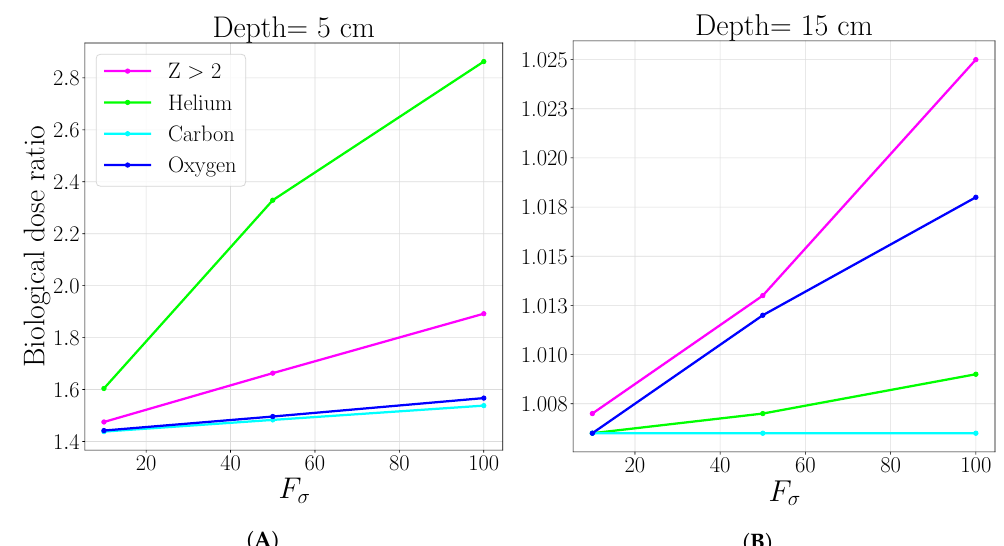
Figure A2. Ratio between the biological dose obtained by considering a modified cross-section for (separately) Helium, Carbon, Oxygen, Z > 2 and the biological dose of primary protons, at 50 mm depth ( A ), 150 mm ( B ) as a function of cross-section scaling factor F σ = 10,50 and F σ = 100 as a limit calculation to give an idea of the asymptotic behaviour. The legend stands for both